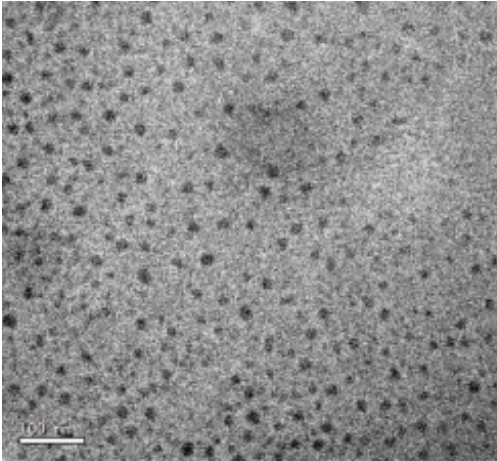
Figure 2. TEM image of C-dots.